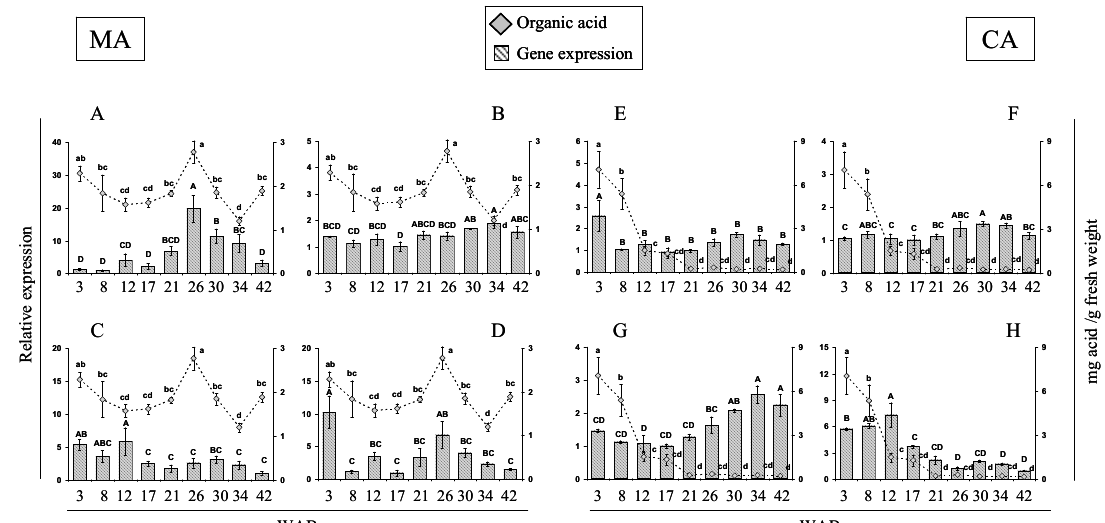
Figure 1. Expression profiles of putative organic acid-related genes during the growth of cherimoya cv. “Concha Lisa”. Quantitative real-time PCR assays were performed in duplicate on samples from 3 to 42 weeks after blooming (WAB). The genes analyzed related to malic acid (MA) were, ( A ) phosphoenol pyruvate carboxylase, AcPEPC ; ( B ) cytoplasmic NAD-dependent malate dehydrogenase, Ac-cyNAD-MDH ; ( C ) NADP-dependent malic enzyme, AcNADP-ME ; and ( D ) NAD-dependent malic enzyme, AcNAD-ME . The genes analyzed related to citric acid (CA) were; ( E ) citrate synthase, Ac-mCS ; ( F ) aconitate hydratase 1, AcACON ; ( G ) NADP-dependent isocitrate dehydrogenase, AcNADP-IDH ; and ( H ) ATP citrate synthase, AcATP-CS . Expression was normalized to a reference gene ( AcUbiq , GenBank FJ664263) and the value is expressed against the lowest value of relative abundance. The relative expression of each gene (bars) was compared with the concentration of the respective acid (gray rhombus). Different letters (capitals for expression and lower cases for activity) between each time point represent significant differences at p ≤ 0.05 by the LSD test.